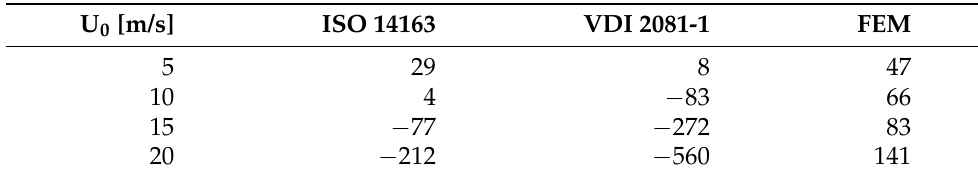
Table 5. Difference between the predicted pressure loss (in Pascals) obtained with ISO 14163, VDI 2081-1 and FEM with that of experimental measurements for the system of splitters with rectangular profiles.